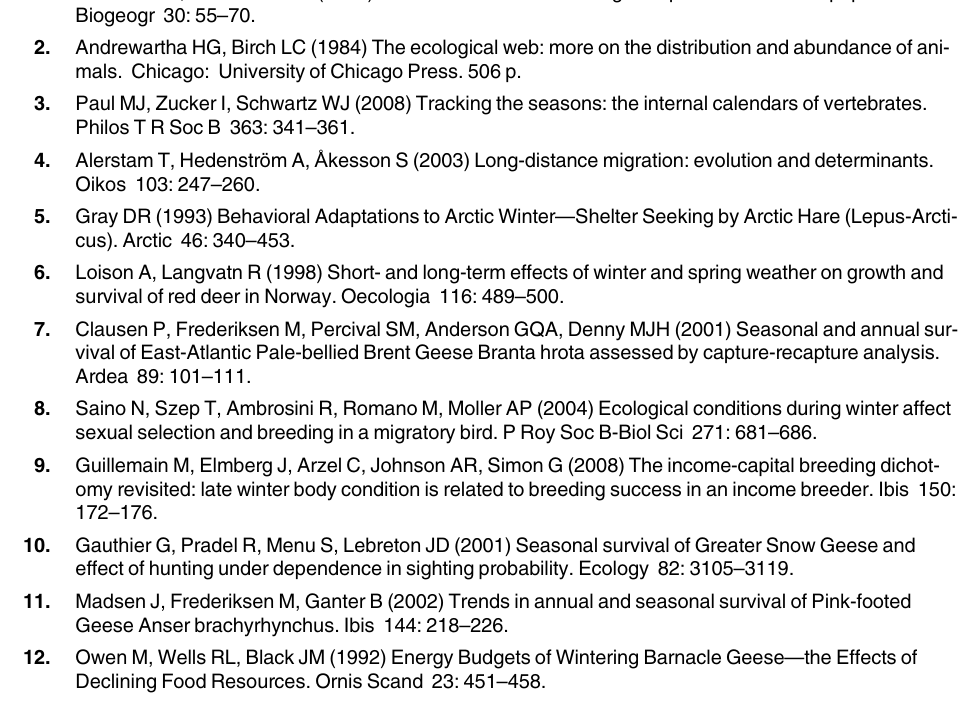
S3 Table. Re-sightings and API assessments of birds included in the current